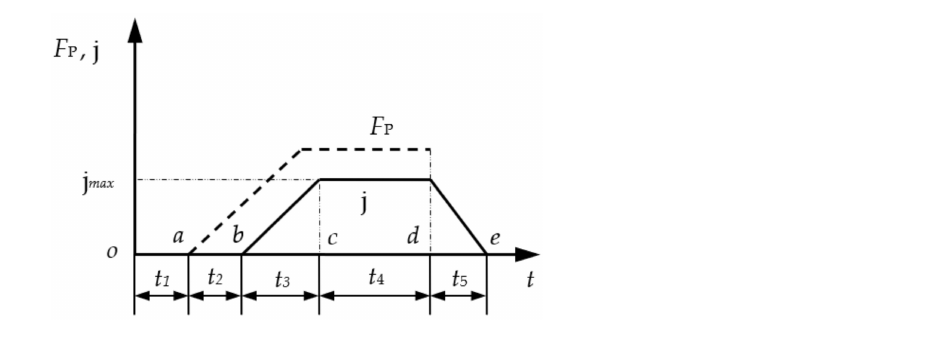
Figure 2. Change curves of brake-pedal force and braking deceleration with time in the process of automobile